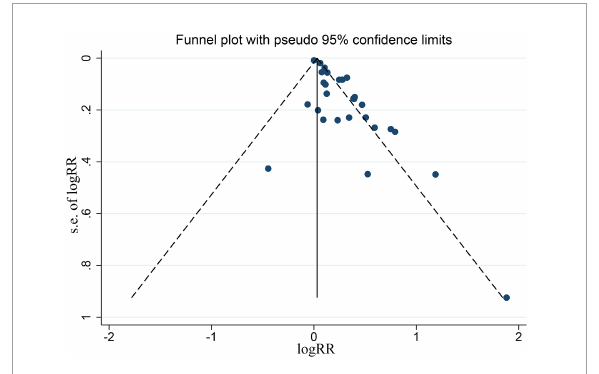
FIGURE8 Funnel plot for all the eligible studies that provided ORs, RRs, or HRs for depression and the risk of